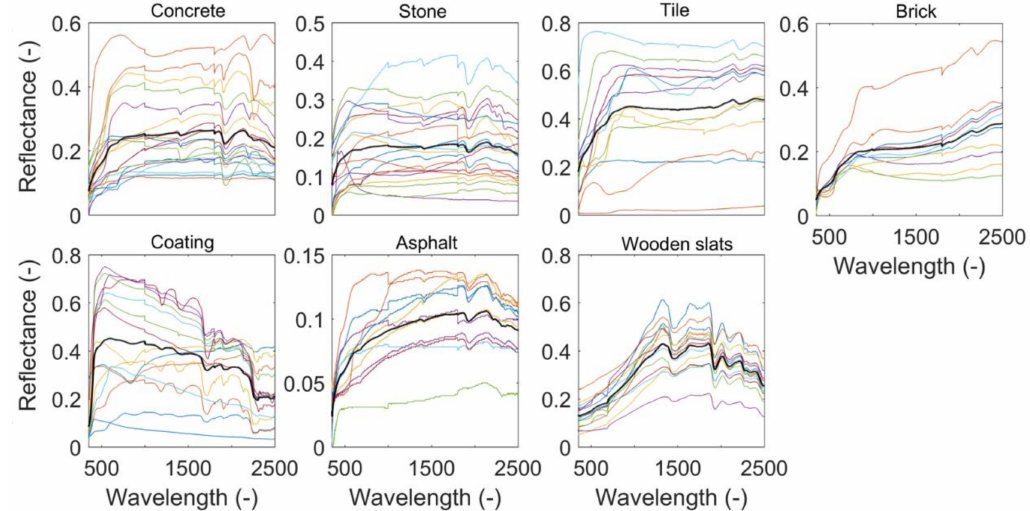
Figure 3. Spectral reflectances of urban surface specimens and the typical spectral reflectance within a single construction material